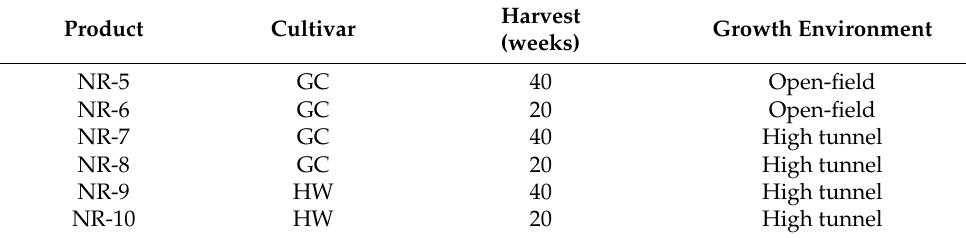
Table 5. Characteristics of Z. officinale Roscoe rhizomes from experimental plots.